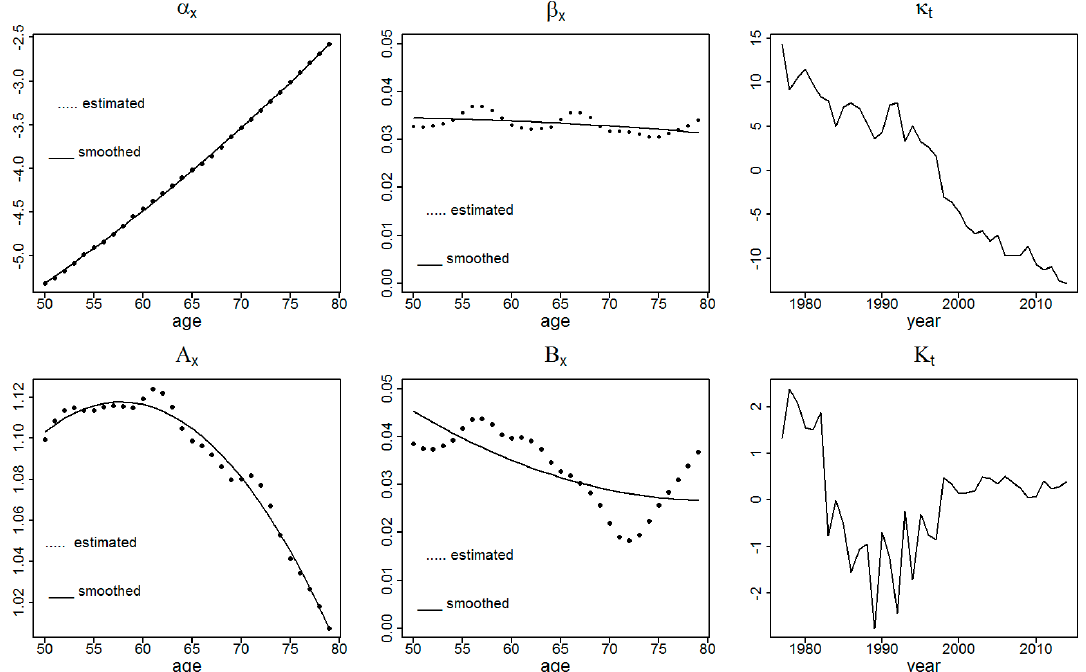
Figure 7 . Coherent model parameters estimation: ( top ) the alpha, beta and kappa parameters, respectively, of the LC model for the joint mortality surface; and ( bottom ) the same parameters issued from the differential mortality function. Alpha and beta were smoothed using two-order polynomial functions to improve the regularity of the projected surfaces.